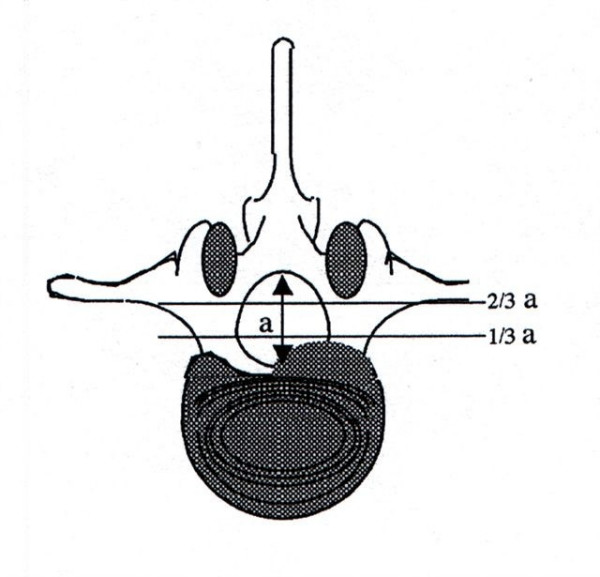
The size of the herniated disc in relation to the spinal canal diameter is measured at disc level.